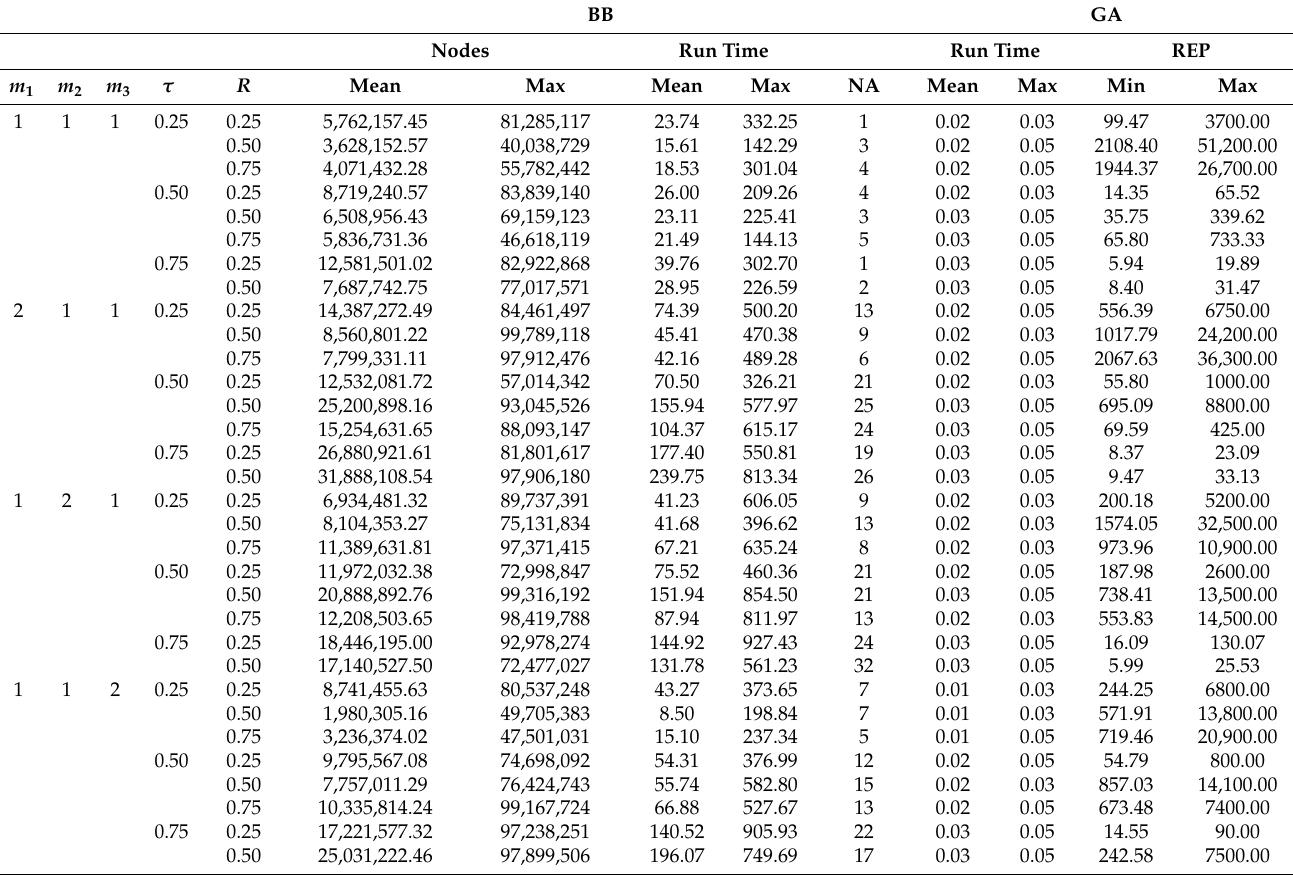
Table 7. The effects of different developers on the performance of BB for n =